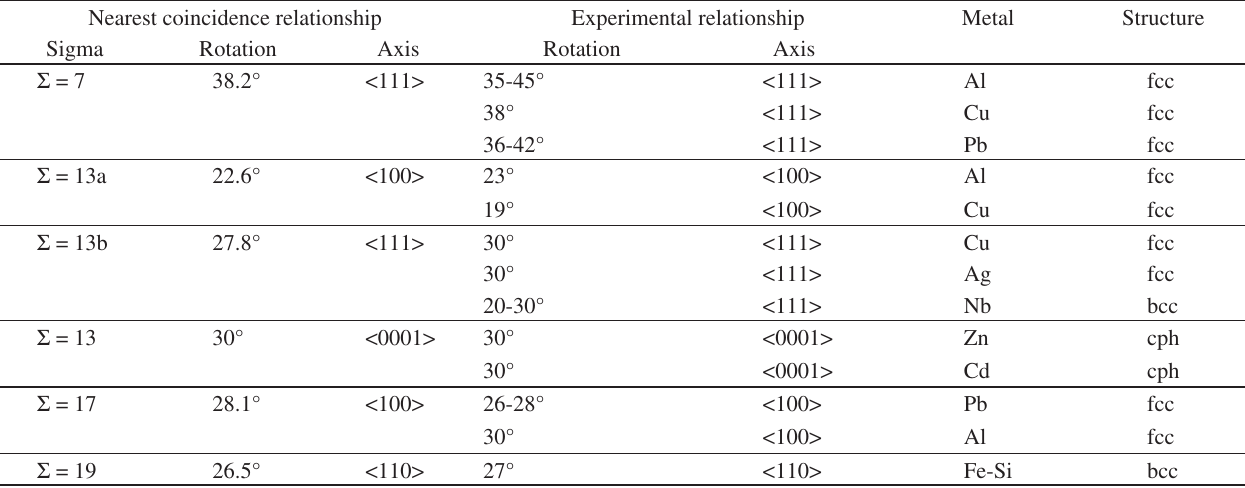
Table 2. Crystallographic orientations for the occurrence of high mobility boundaries 83 .